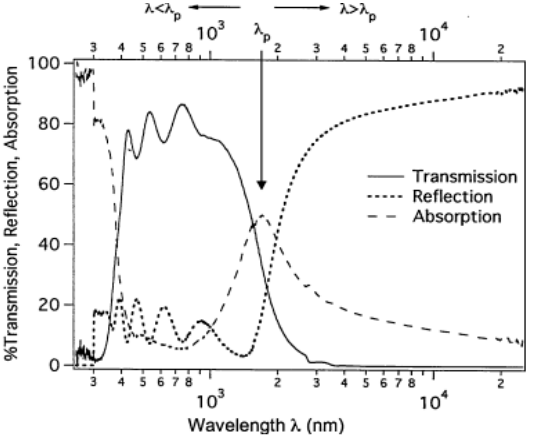
Figure 5. Transmission, reflection, and absorption spectra of a typical TCO [70].